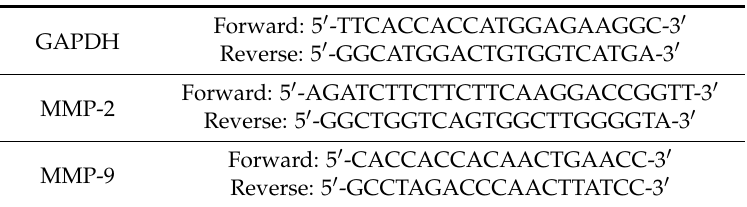
Table 1. The primers for MMP-2 and